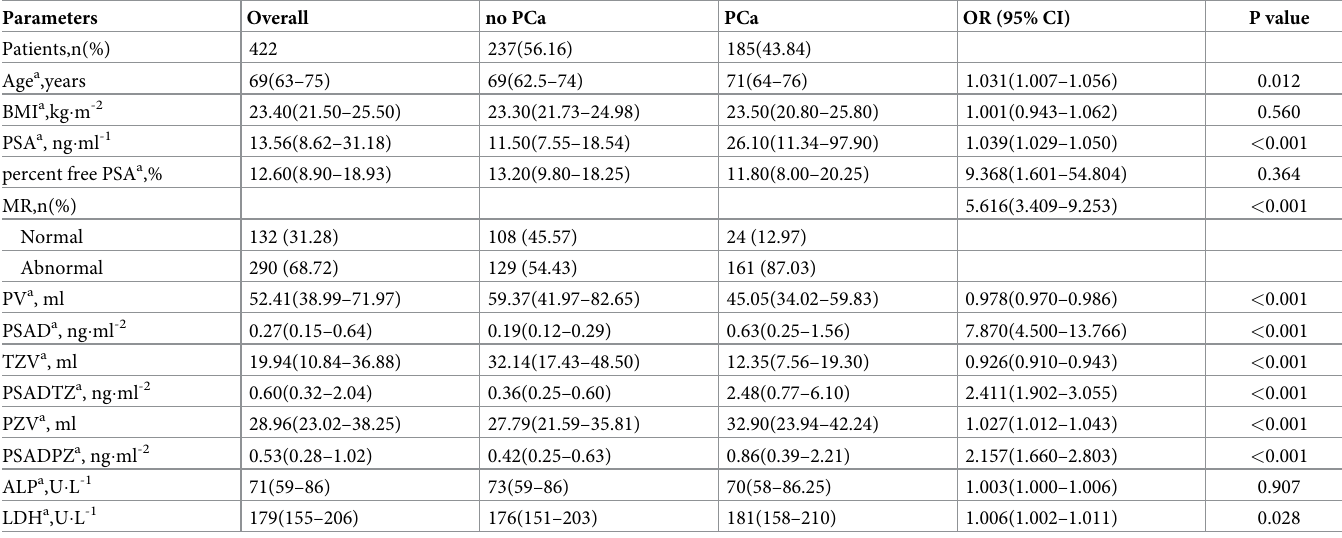
Table 1. Clinical characteristics of patients with no PCa and PCa at the initial